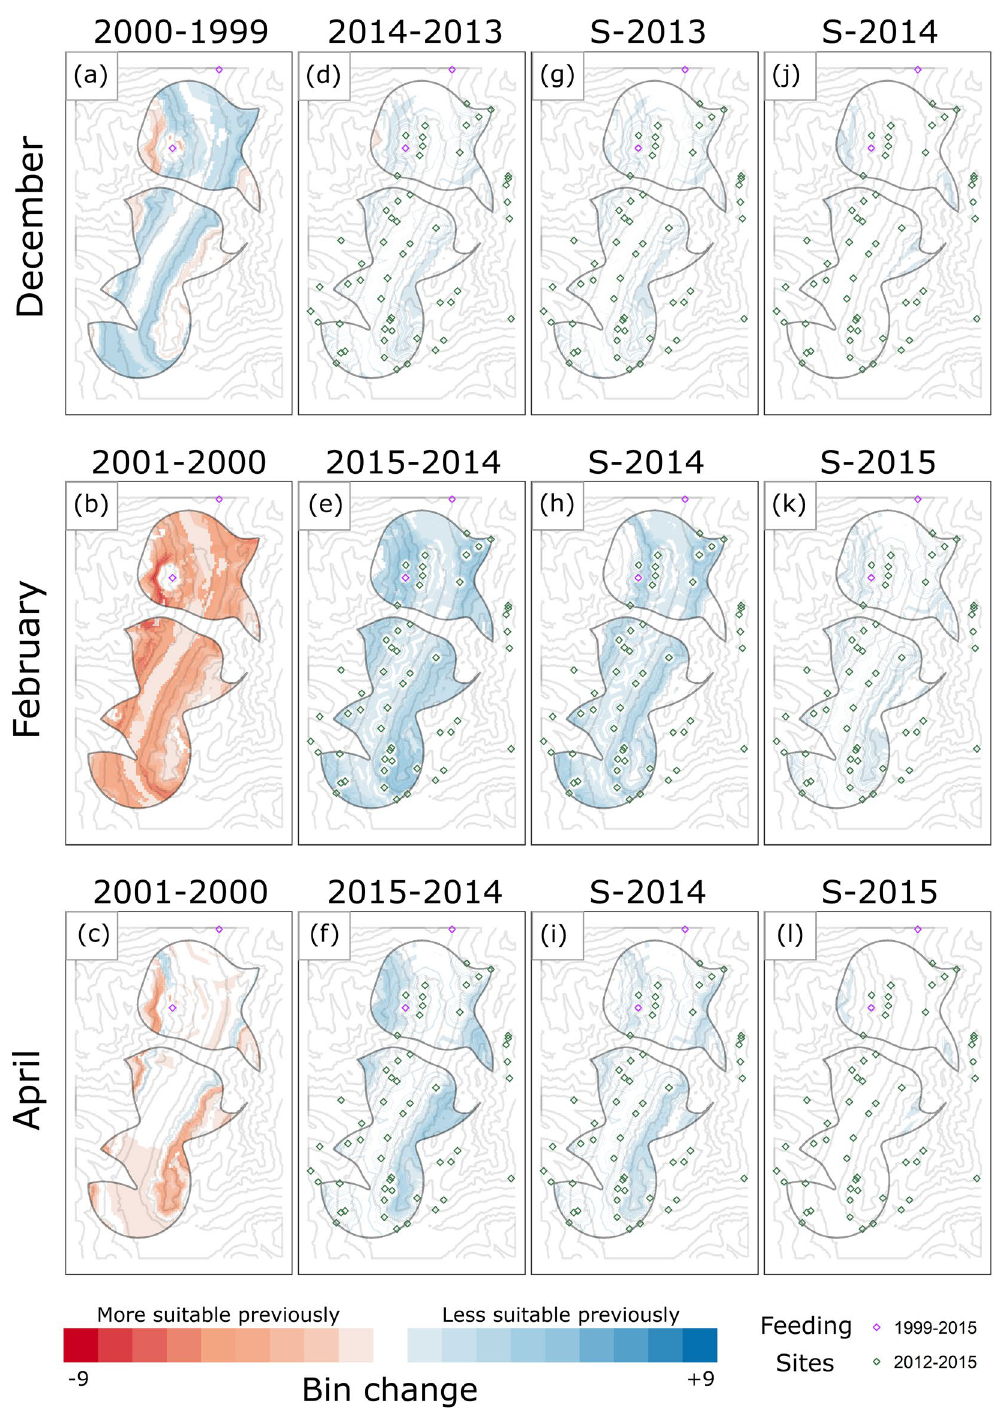
Figure 5. Maps of change in relative probability-of-use ( Rp ). Each map represents the subtraction of one binned Rp map from another (later map–earlier map). Pixel colors range from − 9, indicating extreme preference for the pixel in the earlier year, to + 9, extreme preference in a later year. The spatial resolution is 10 m, and the contour lines indicate 250 m changes in elevation, with lowest values in the central valley (see also Fig. 1). Panels ( a – f ) show subtractions within the historical period ( a – c , low-snow year subtracted from high- snow year) and within the contemporary period ( d – f , high-snow year subtracted from low-snow year); panels ( g – l ) show subtractions of contemporary years (high-snow: 2013/2014 winter; low-snow: 2014/2015 winter) from the same year predicted using the severe forecast